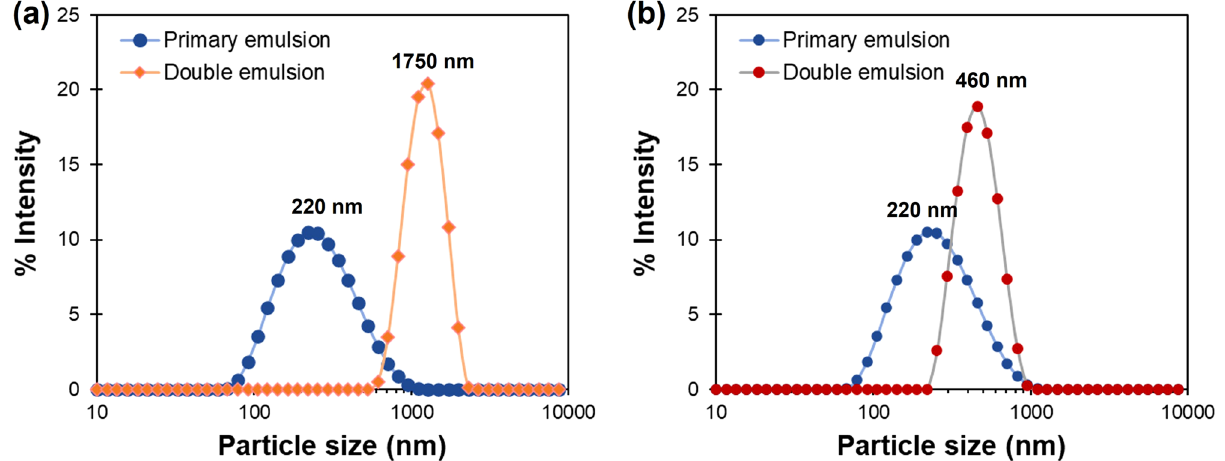
Figure 3. Particle size distribution of a primary W 1 /O emulsion and a double W 1 /O/W 2 emulsion of Eudragit RS100 particles, prepared by using ( a ) ultra turrax (UT) and ( b ) ultrasound (US) in the secondary step.